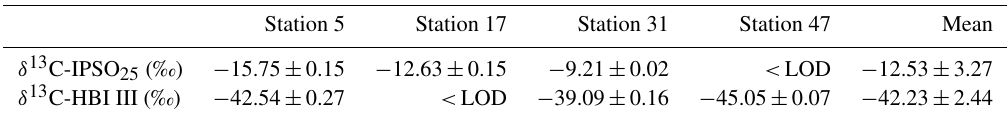
Figure 3. Oceanographic data: (a) maximum ice cover during the previous winter (August–September–October 2002). (b) Ice cover 30 days before each station was occupied. (c) Surface temperature. (d) Surface salinity. (e) Maximum density gradient per 10m water column. (f) Mixed layer depth. (g) Total chlorophyll a (chl a ) concentration of cells >0.2µm. (h) Proportion of large phytoplankton (>12µm) based on size-fractionated chl a measurements (% of total chl a ). Table 1. Euphausia superba : carbon isotopic signature ( δ 13 C) of IPSO 25 and HBI III extracted from ∼ 30 pooled, whole krill (mean ± SD, n = 3) at four sampling locations near the retreating ice edge. LOD is below limit of